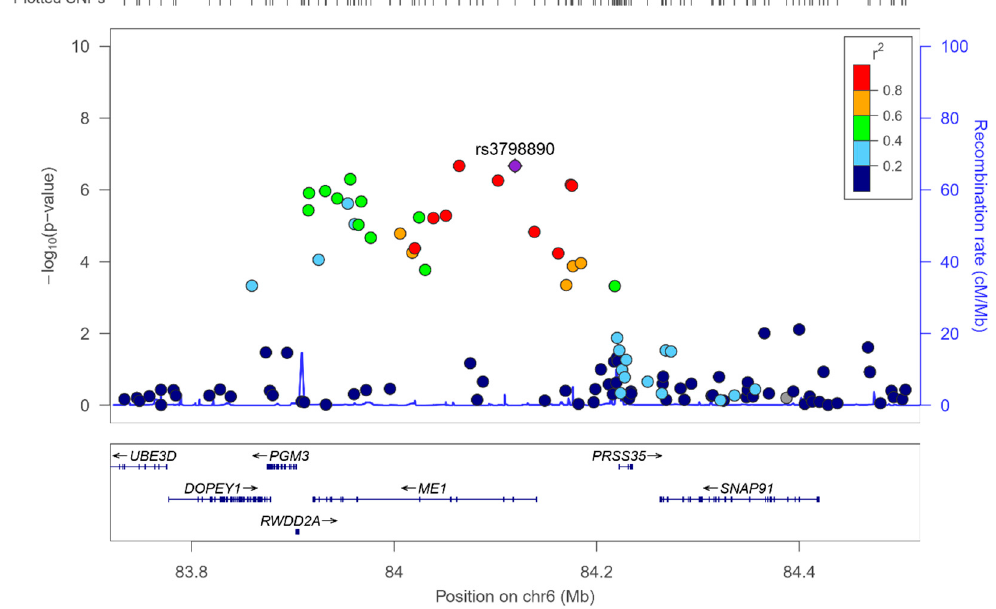
Figure 6. Regional plot for the top-ranked SNP rs3798890 (hit in the genome-wide interaction study with Mediterranean diet in determining serum omega-3 fatty acid), located in the ME1 gene, on chromosome 6. Results for the whole population.